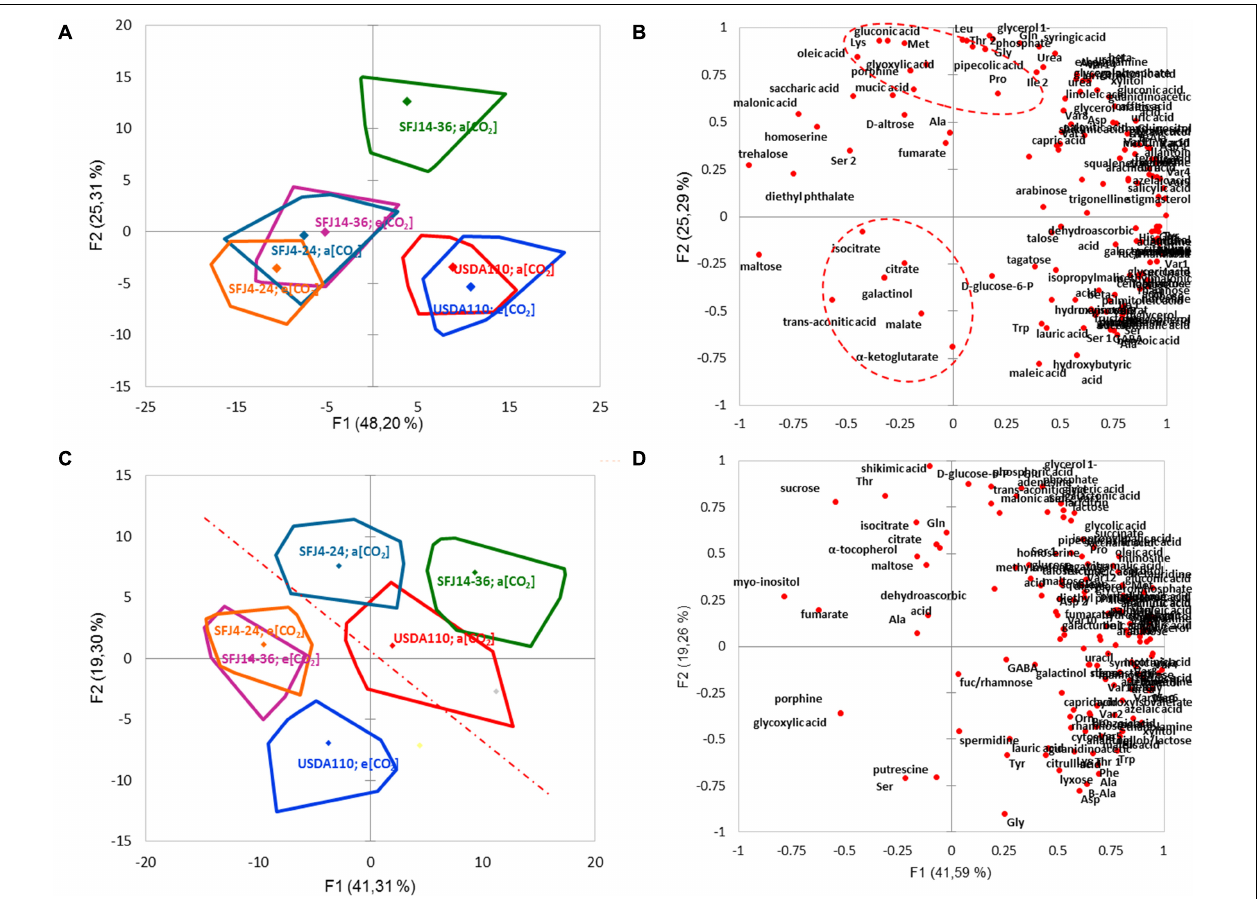
FIGURE 5 | Graphical representation of metabolomic response to different [CO 2 ] in soybean plants inoculated with three B. japonicum strains. Principal component analysis (PCA) [ (A) nodules and (C) leaves] of the different metabolites in soybean plants inoculated with three B. japonicum strains. Scatter plot distribution [ (B) nodules and (D) leaves] of the different metabolites in soybean plants inoculated with three B. japonicum strains. Three replicates were examined per strain and CO 2